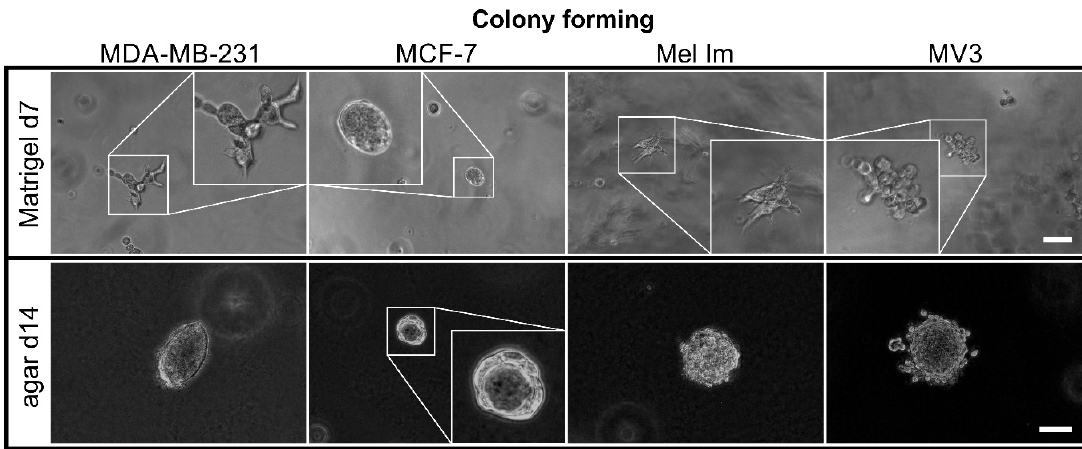
Figure 1. Phase contrast images of cell lines in Matrigel (top) and agar (bottom); all cell lines (MDA- MB-231, MCF-7, Mel Im, and MV3) were able to form multicellular colonies from single cells in both matrices; scale bar = 100 µm.